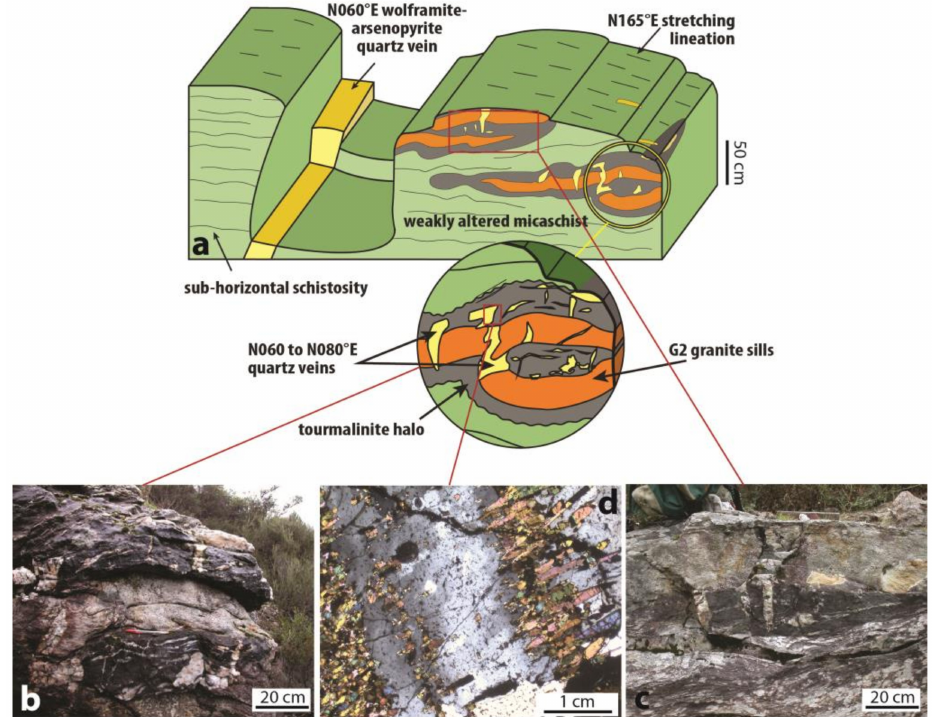
Figure 11. ( a ) Mina Soriana outcrop, Galicia (Spain), showing the development of mineralised quartz veins thanks to tourmaline-rich alteration halos developed in response to granitic sill emplacement (modified from [59]). ( b ) Close view of the granitic sill, tourmaline halo and vertical quartz veins. ( c ) Microscopic view of quartz vein rim showing tourmaline syntectonic growing. ( d ) Development of vertical quartz mineralised veins limited to the tourmaline-rich alteration